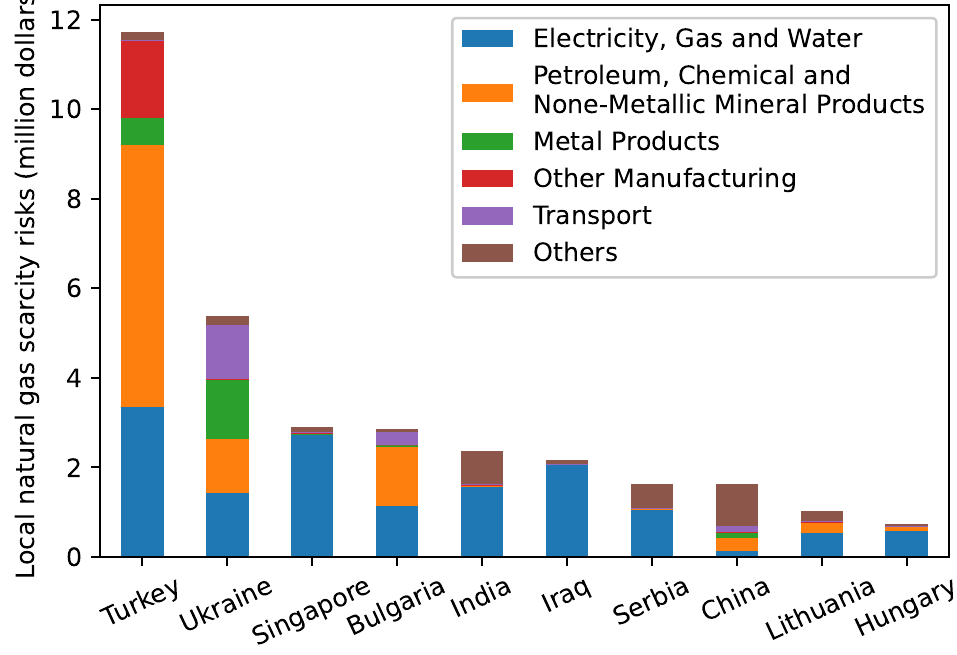
Figure 3. Local natural gas scarcity risks. Five main sectors in top ten countries suffered natural gas scarcity-induced economic risk are